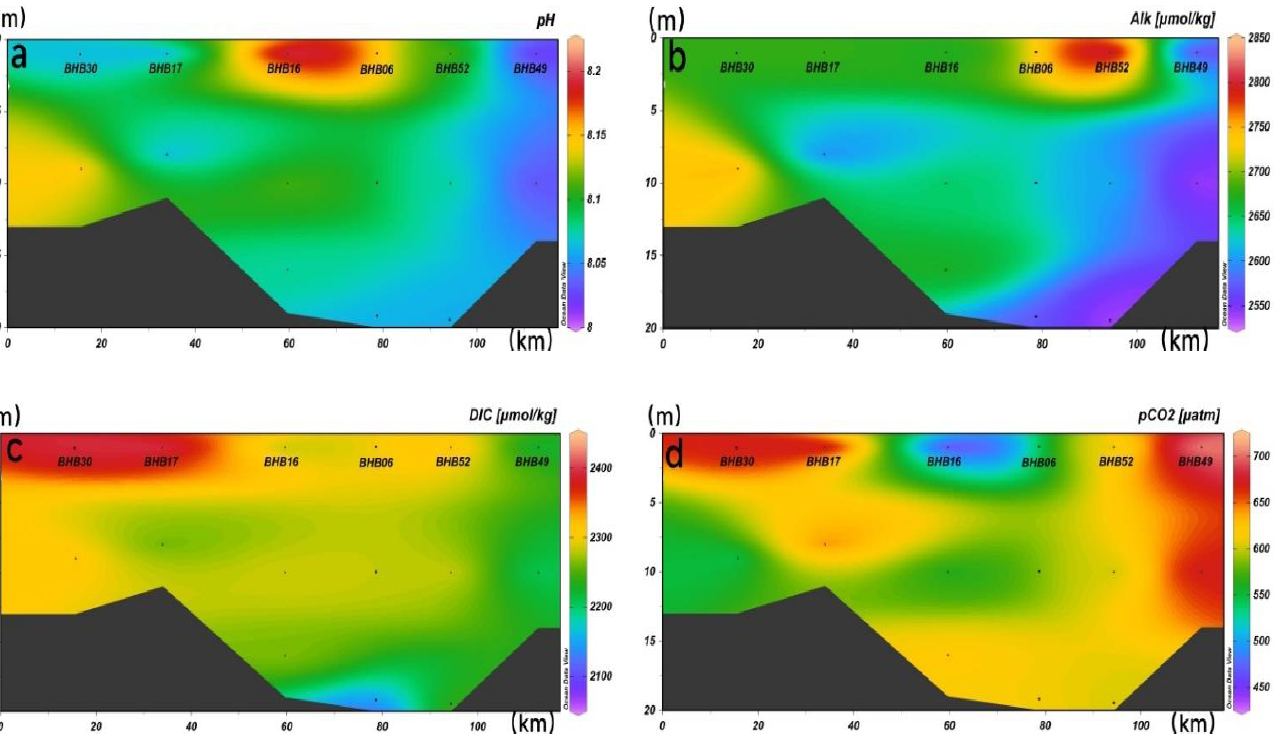
Figure 8. Vertical distributions of pH ( a ), Alk ( b ), DIC ( c ) and p CO 2 ( d ) in transect A of Bohai Bay in summer 2020. This image was created with ODV software, version 5.3.0 (Alfred Wegener Institute, Bremerhaven, Germany).